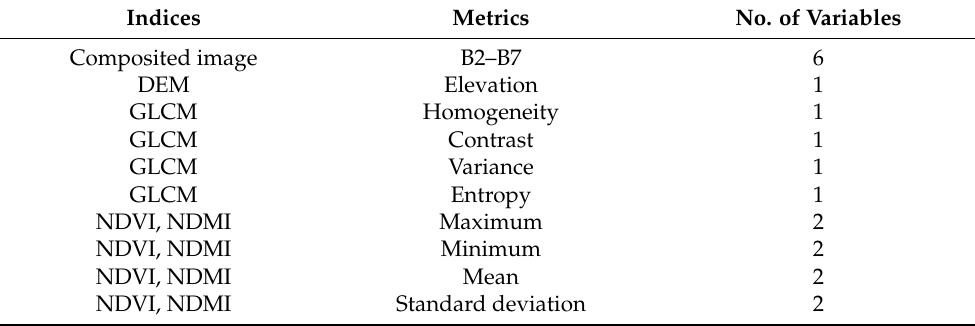
Table 4. Variables used for bamboo mapping in all bamboo provinces of China, except Hainan. Indices Metrics No. of Variables Composited